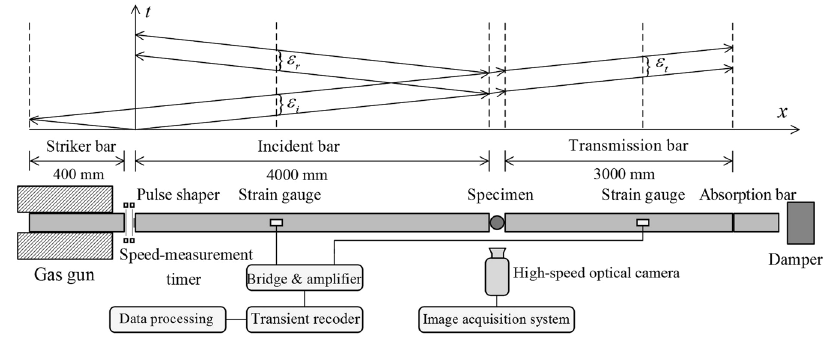
Figure 5. Schematic of a SHPB system and its x − t diagram of stress wave propagation.